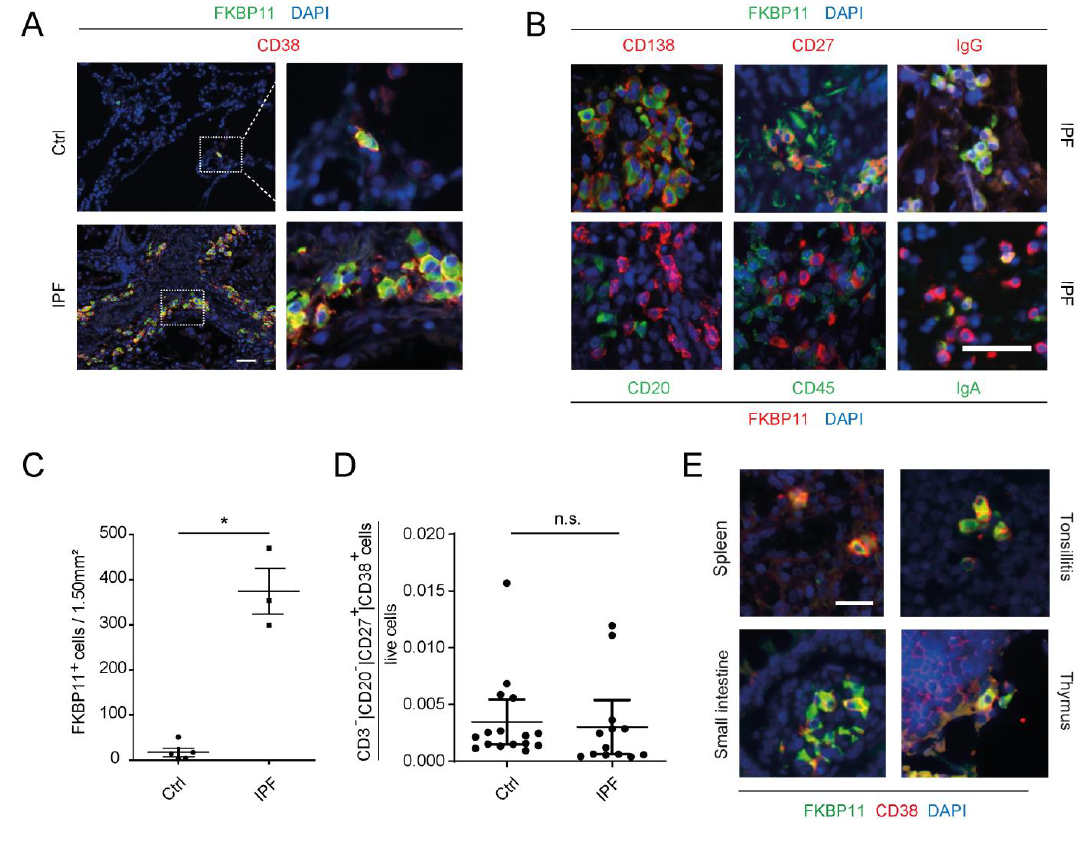
Figure 2. FKBP11 is expressed by CD27 + /CD38 + /CD138 + /CD20 − /CD45 − plasma cells. ( A ) Im- munofluorescent stainings in control (Ctrl, upper panel) and IPF lung tissue sections (lower panel) demonstrate expression of FKBP11 in CD38 + plasma cells. Stainings are representative for n = 5 (Ctrl) and n = 3 (IPF). Scale bar 40 µ m. ( B ) Immunofluorescent stainings in IPF lung tissue sections further demonstrate that FKBP11 + plasma cells are positive for CD138, CD27 (upper panel), but negative for CD20 and CD45 (lower panel) and produce mainly IgG (upper panel, far right), but also IgA (lower panel, far right). Note, that secondary antibody dyes for FKBP11 differ in upper and lower panel. Stainings of IPF lung sections are representative for n = 2 (CD138, CD27, CD20, CD45) and n = 3 (IgG, IgA). Scale bar, 40 µ m. ( C ) Quantification of CD38/FKBP11 immunofluorescent stainings ( A ), based on lung sections from normal histology controls ( n = 5) and IPF patients ( n = 3, observer blinded to diagnosis), where FKBP11 + /CD38 + cells from ten randomly selected images sized 1.5 mm 2 were counted and added up for all 10 images ( p = 0.0357, two-tailed Mann-Whitney ( D ) Numbers of circulating CD20 − /CD27 + /CD38 + plasma cells were not significantly changed ( p = 0.2680, two-tailed Mann-Whitney test) between healthy subjects ( n = 20) and IPF patients ( n = 13). ( E ) Immunofluores- cent stainings of a human tissue array demonstrated FKBP11 + /CD38 + cells in other tissues than lung, namely spleen, tonsils, thymus, and small intestine. Scale bar 20 µ m. * p < 0.05; n.s., not